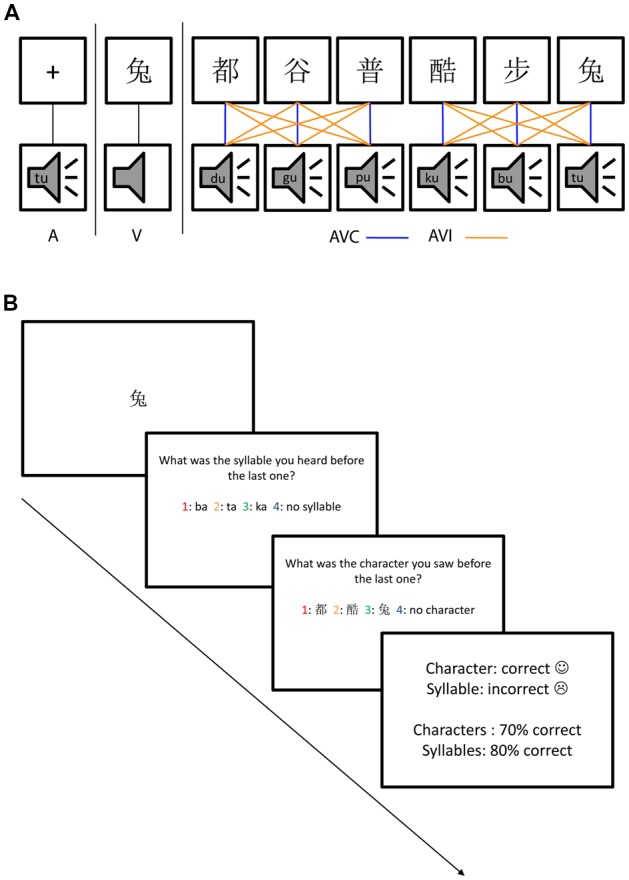
The audiovisual stimuli and dual one-back task. (A) Stimuli consisted of auditory only (A), visual only (V), audiovisual congruent (AVC) and AV incongruent (AVI) conditions using six Chinese characters and their corresponding speech sounds. The AVC combinations were indicated by blue lines and the incongruent combinations were indicated by yellow lines. The comparison between uni- and multimodal stimuli will reveal suppression effects while comparing the two multimodal conditions will reveal congruency effects. (B) The four types of stimuli (A, V, AVC, AVI) were presented randomly, as well as the cover task trials which occurred with 7.5% probability and consisted of one question for auditory, one for visual stimulus followed by feedback. The order of auditory and visual questions was also randomized.